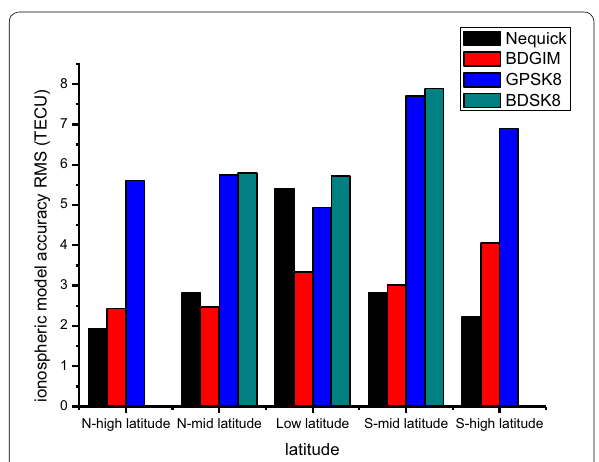
Fig. 4 Evaluation of the ionospheric model accuracy in half a year based on CODG model